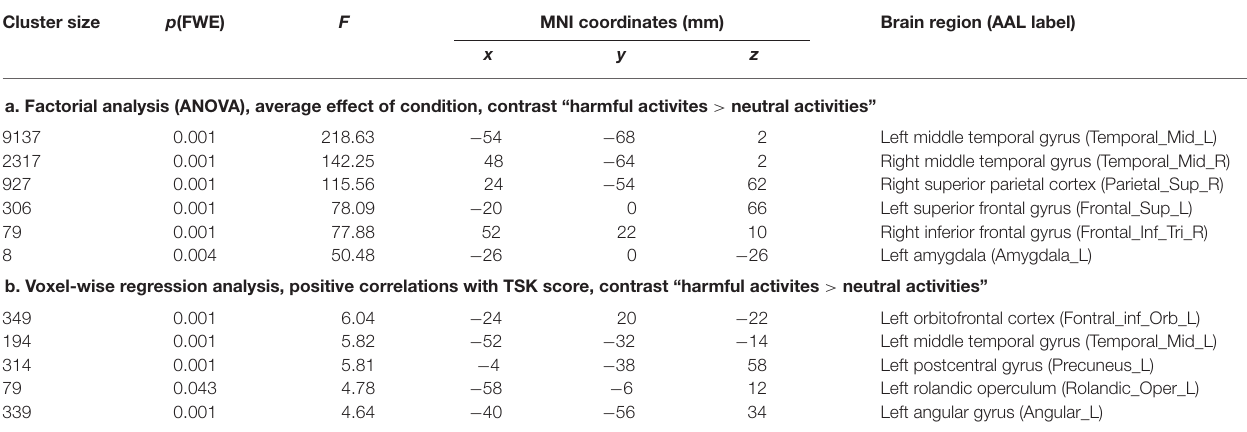
TABLE 2 | Cluster maxima and their respective coordinates. Cluster size